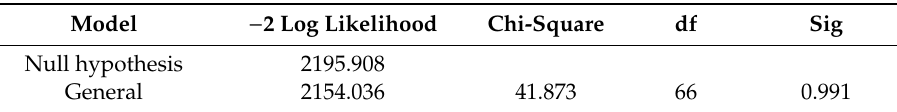
Table 4. Test of Parallel